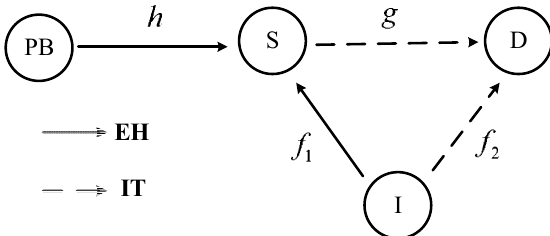
Figure 1. System model. PB, power beacon-assisted node; EH, energy harvesting; I, co-channel interference from the environment; IT, information transmission; S, source node; D, destination node; f 1 , I-S interference channel; f 2 , I-D interference channel; h , PB-S channel; g , S-D channel.